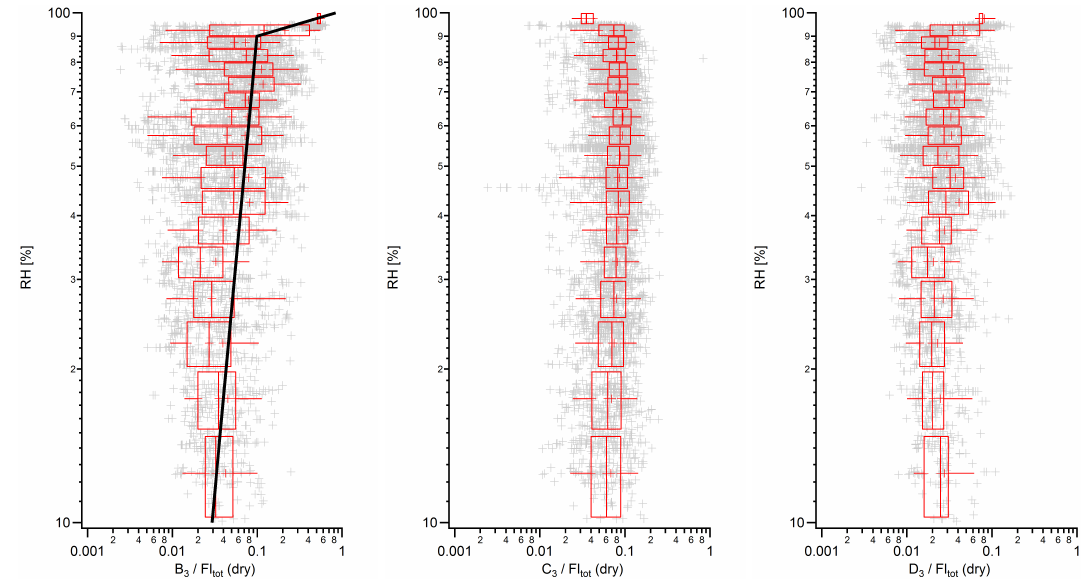
Figure 11. Ratio of fluorescent cluster number concentration to total fluorescent particle concentration (Fl tot ) as a function of relative humidity (RH%) in dry conditions. Left to right; cluster B 3 ; cluster C 3 ; cluster D 3 ; whiskers represent the 5th and 95th percentiles; boxes show inter-quartile range with the central marker being the median and the mean is shown with a cross marker. A linear fit in log–log space has been added to B 3 (see Eq. 3). Norm of residuals: B 3 / Fl tot (dry, RH < 90%)=0.37; B 3 / Fl tot ( dry, RH ≥ 90 % ) = 0 . 02 .